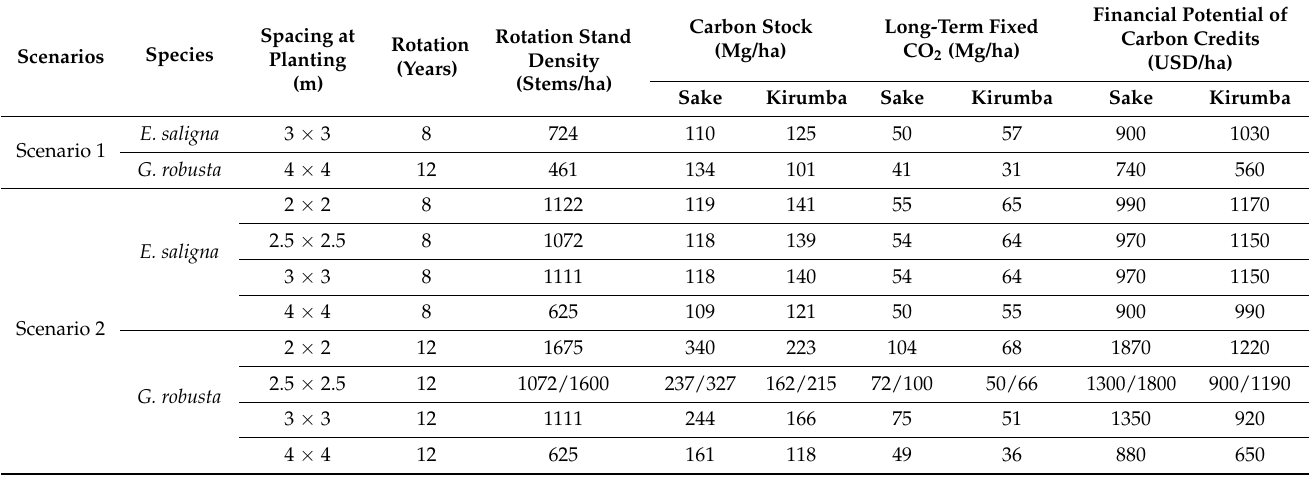
Table 6. Carbon stock, long-term CO 2 fixation and financial potential of carbon credits in E. saligna and G. robusta plantations in North Kivu. The carbon stock was calculated from Models 5 (for E. saligna ) and 10 (for G. robusta ). Long-term fixed CO 2 and the financial potential of carbon credits were deducted from the carbon stock following the methodology described in Section 2.4.6. The rotation stand density corresponds to the stand density after thinning (see Table